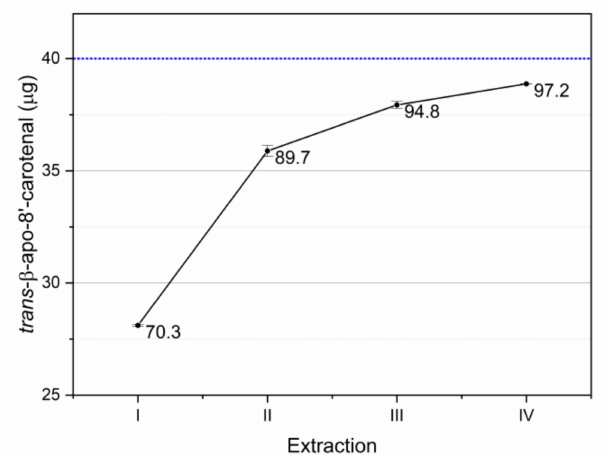
Figure 7. Recovery of the internal standard added to the sample before extractions. Blue reference line indicates the spiked amount. Data labels indicate the cumulative percent recovery after each extraction step of the tested extraction protocol. Error bars indicate standard deviation.